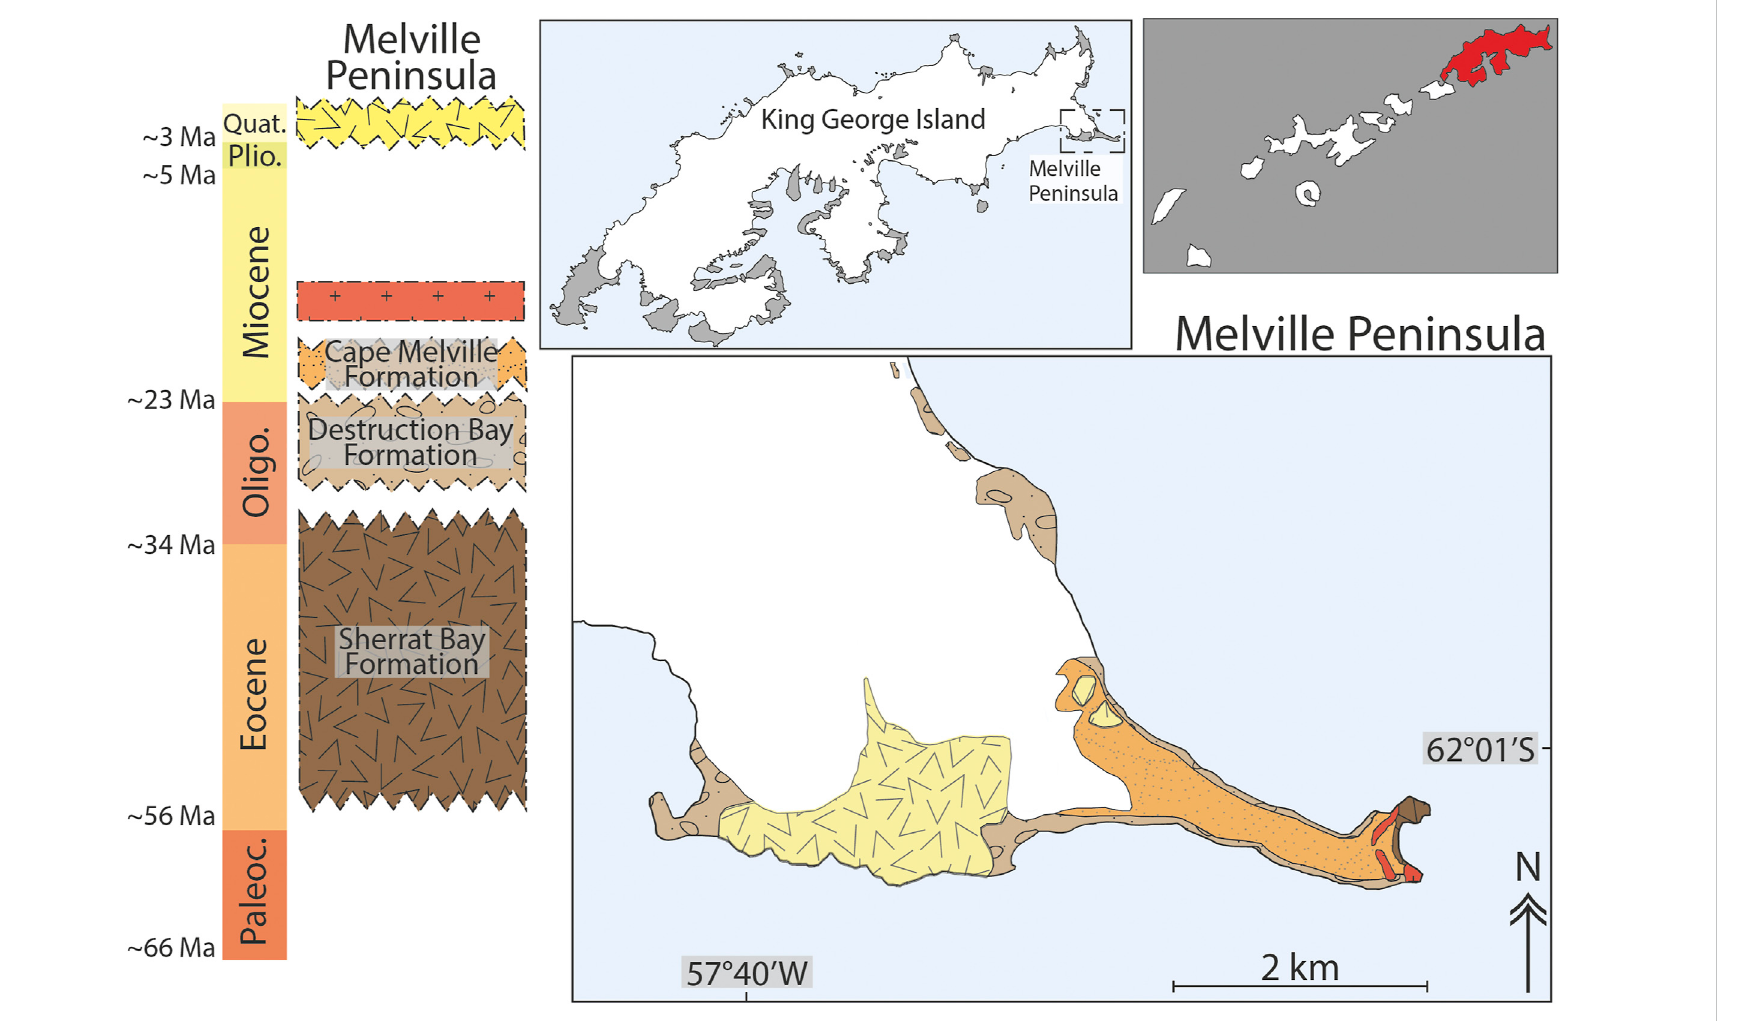
FIGURE 14 Geological map of Melville Peninsula, King George Island, modi fi ed from Smellie et al. (2021b) and Warny et al.